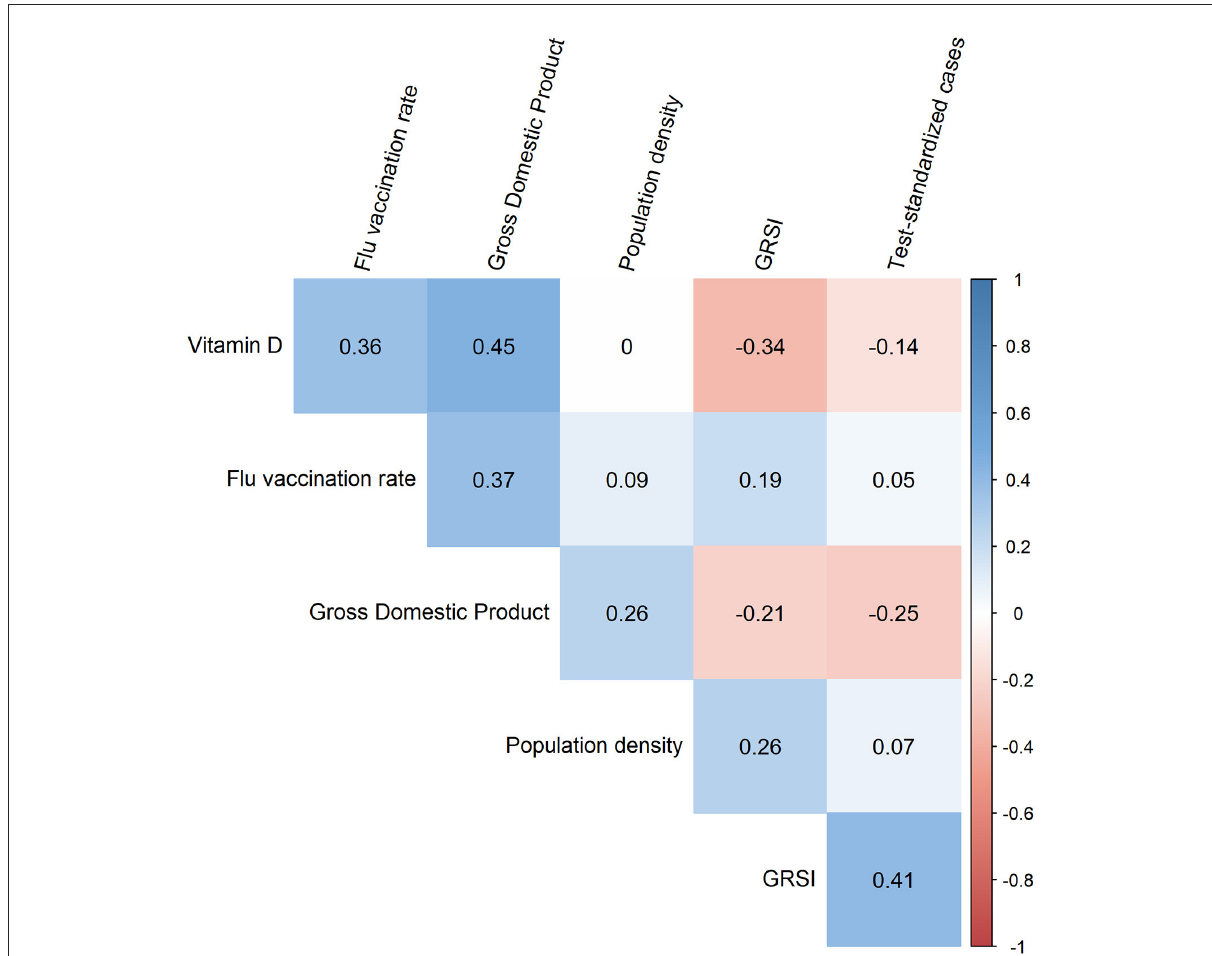
FIGURE3 Corrgram showing the Spearman correlation coefficients for all pairs of the six variables included in the best model. The strongest correlation was observed between vitamin D and the gross domestic product which was almost significant ( p =